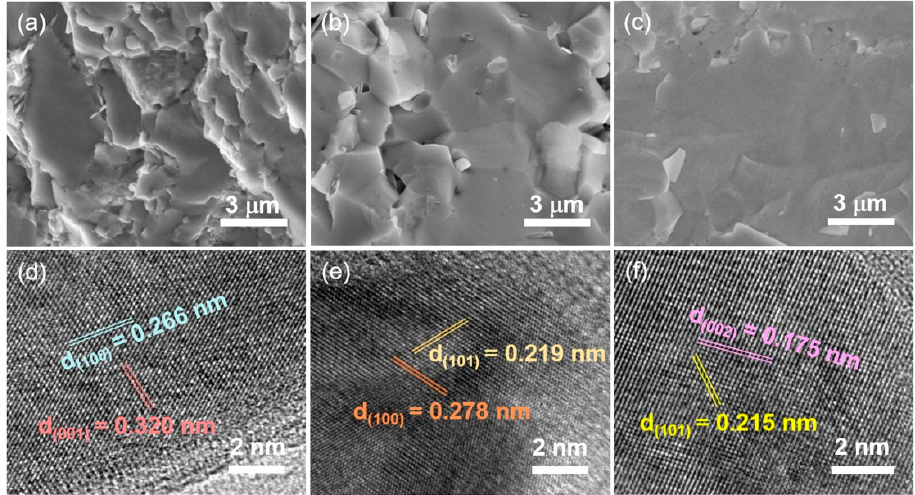
Figure 2. The SEM images of ( a ) TiB 2 , ( b ) ZrB 2 and ( c ) HfB 2 after HPHT treatment, and the corre- sponding HRTEM images of ( d ) TiB 2 , ( e ) ZrB 2 and ( f ) HfB 2 .